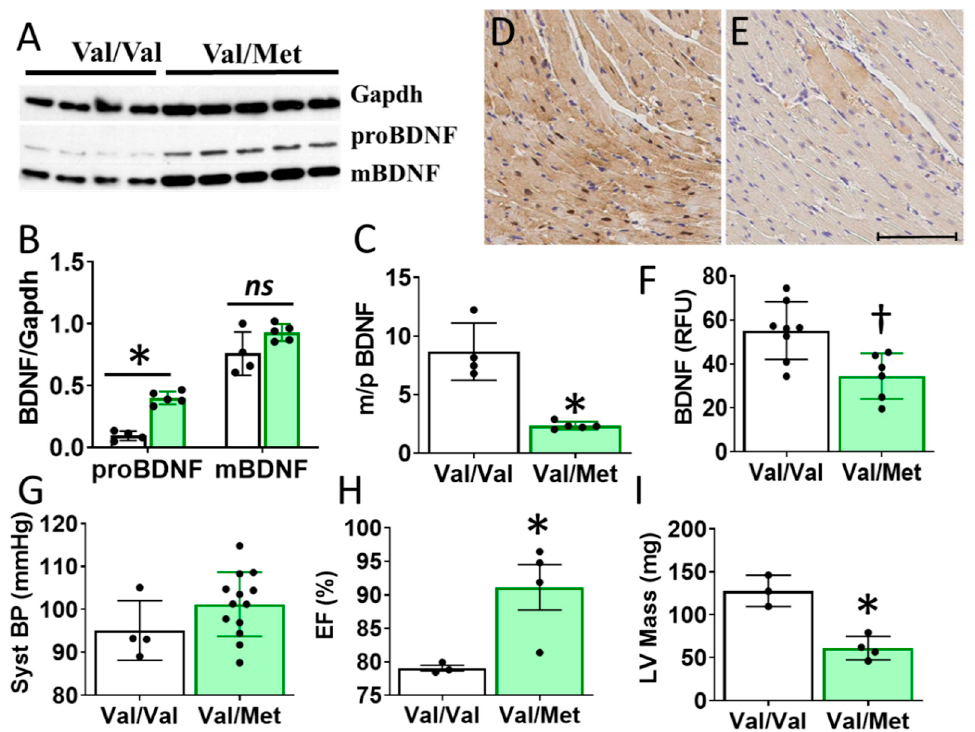
Figure 3. Val66Met mice have increased BDNF in tissue lysates and altered cardiac function as measured by echocardiography. ( A ) Western blot of left ventricular cardiac tissues from Val66Met mouse for proprotein brain-derived neurotrophic factor (proBDNF) (~27 kDa, middle) and mature BDNF (mBDNF) cleavage product (~14 kDa, bottom). ( B ) Bar graph of densitometry analysis of pBDNF and mBDNF normalized to gapdh (y axis) for Val/Val (white bars, n = 4) and Val/Met (green bars) ( n = 5). ( C ) Bar graph showing processed BDNF as a ratio of mBDNF/proBDNF (m/p). ( D,E ) Anti-BDNF-DAB stained hearts from Val/Val ( D ) and Val/Met ( E ) mice at 20X magnification, scale bar = 100 μ m. ( F ) Bar graph showing quantification of whole hearts from V ( n = 8) and Val/Met ( n = 6) mice relative to total tissue area. ( G ) Plot showing systolic blood pressure (mmHg) as measured by tail cuff for Val/Val ( n = 4) and Val/Met ( n = 13). ( H,I ) Results of echocardiography assessment of Val/Val (white bars, n = 3) and Val/Met (green bars, n = 4) mice are shown. Parameters shown (y axis) are ( H ) percent (%), ejection fraction (EF); ( I ) LV mass (corrected). Asterisks represent statistical significance for V versus VM * p < 0.0001 ( B ), * p < 0.0006 ( C ), † p = 0.0079 ( F ), * p = 0.0302 ( H ), * p = 0.0026 ( I ).